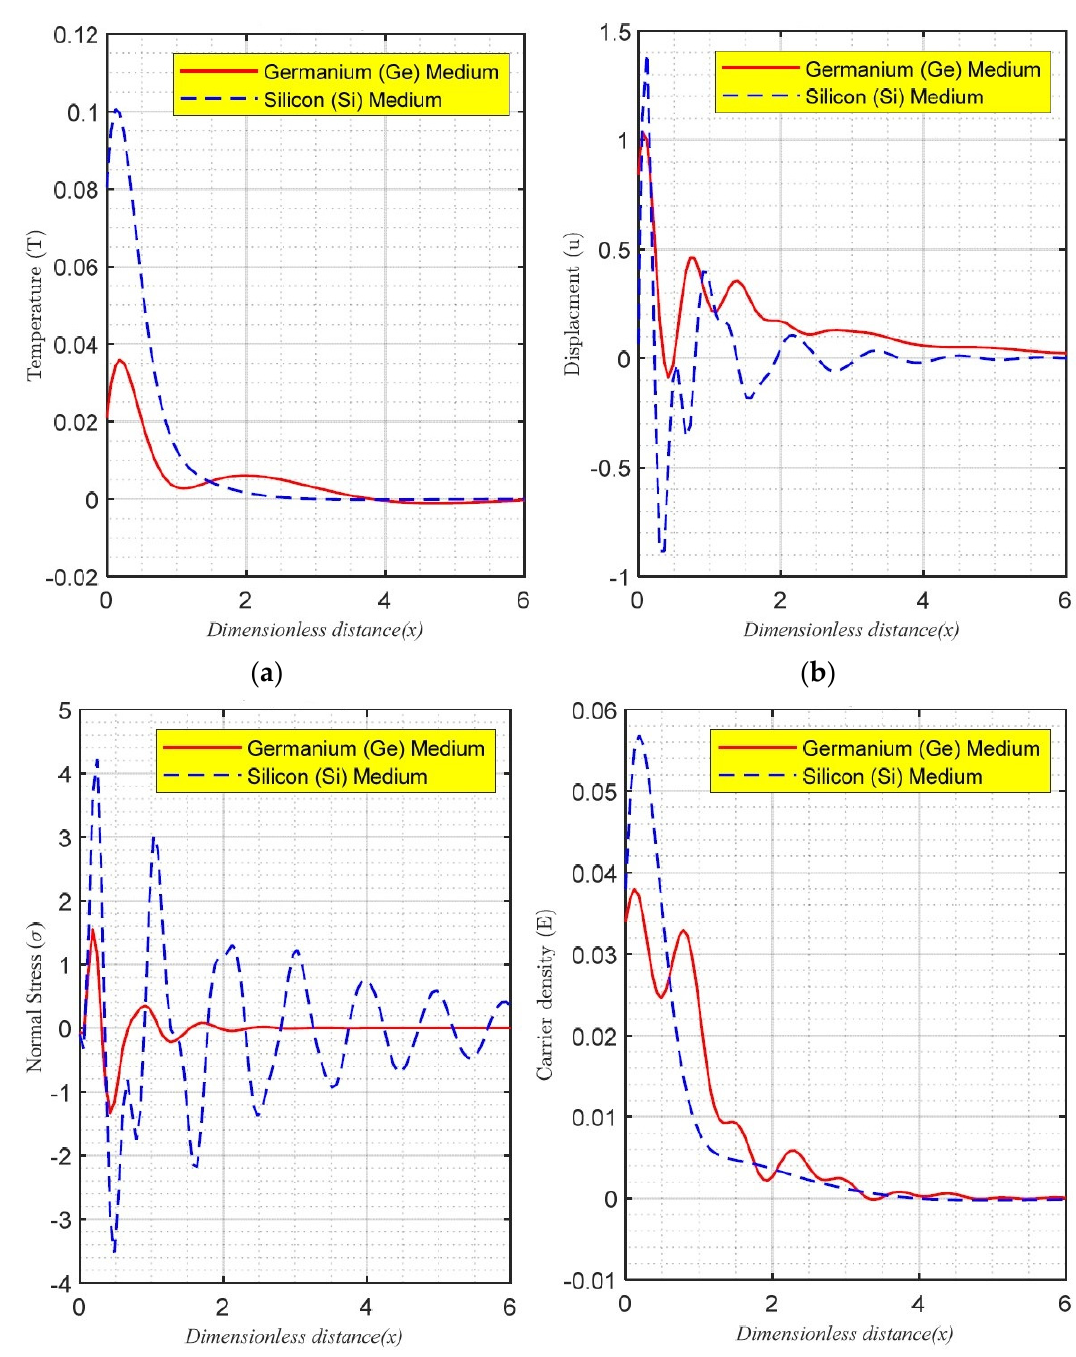
Figure 4. ( a – d ) The comparison between the physical field distributions against the distance according to the different physical constants of Si and Ge materials in the context of the DPL model.